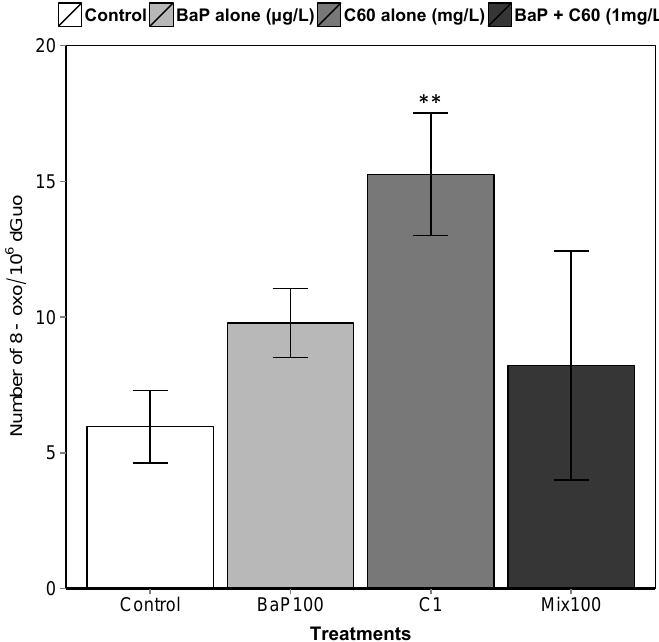
Figure 4. 8-oxodGuo levels in the digestive gland of mussels. Asterisks indicate the statistical di ff erences observed between control and exposed groups. (**) p < 0.01. Table 1. Analysis of combined e ff ects of B[a]P and C 60 on DNA damage based on Interaction Factors